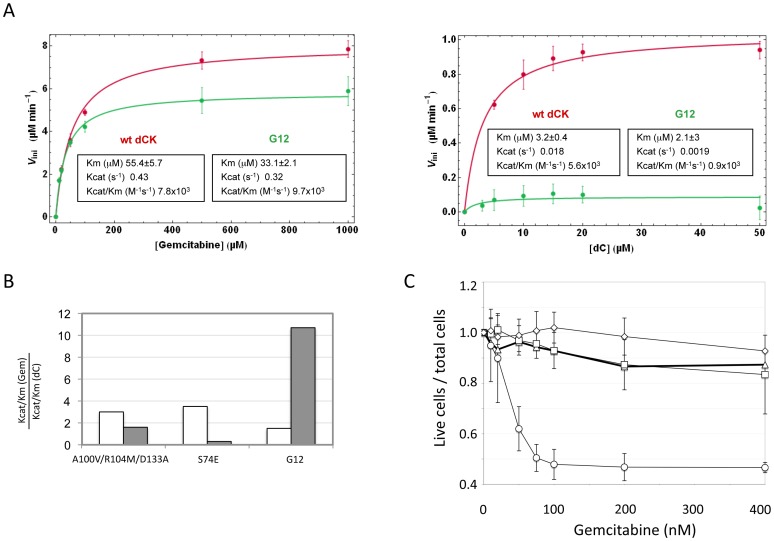
Biochemical characterization of G12.
Panel A. Phosphorylation kinetics of wt-dCK and G12 mutant overexpressed in E.coli. Steady state kinetic data of wt and G12 dCK fitted according to the Michaelis-Menten equation. Panel B. Ratio of the values of Kcat/Km for gemcitabine (Gem) with respect to the values of Kcat/Km for the natural substrate dC for the triple mutant A100V/R104M/D133A, described in reference [19], for the S74E mutant, described in reference [20], and for the G12 mutant, described here. The value found in each of the three studies for the wt dCK is given in white, while that of the respective mutant is given in grey. Panel C. Viability of selected Messa10K “polyclonal populations” transduced with vectors containing the wt dCK (squares), mutant G12 (circles), or the triple mutant A100V/R104M/D133A [19] (diamonds), and of untransduced Messa 10K cells (triangles), in the presence of increasing concentrations of Gemcitabine.